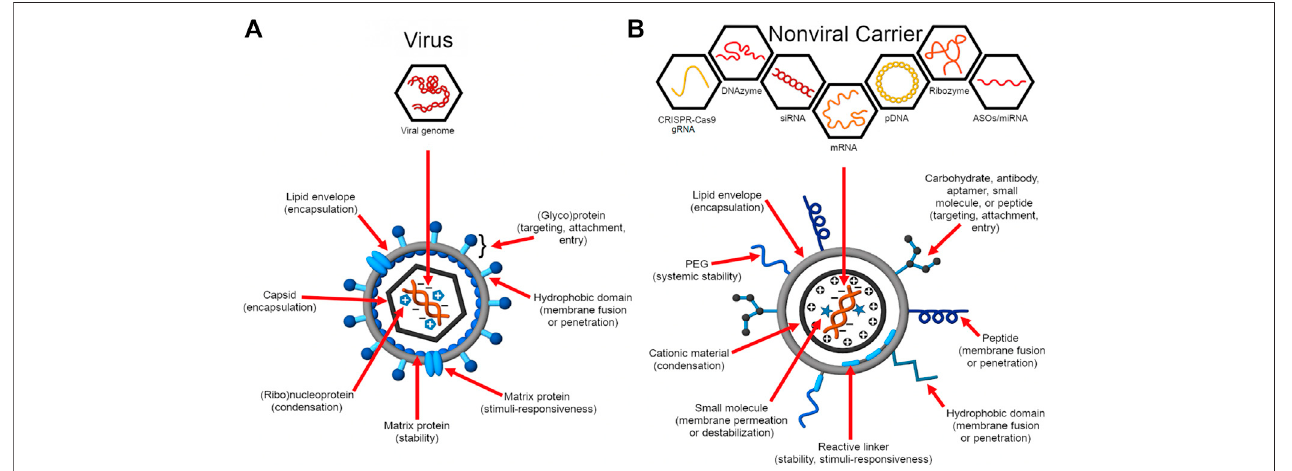
FIGURE 1 | Virus structure and function inform the design of nucleic acid delivery systems. (A) Viruses evolve to deliver their genome ef fi ciently to the host cell for replication (Flint et al., 2015). As such, their genome encodes proteins essential for genome protection, tropism, intracellular traf fi cking, controlled genome release, and replication. (B) SyntheticcarriersaredesignedtodeliveradiversityoftherapeuticnucleicacidcargoincludingpDNA,siRNA,ASOs,miRNA,mRNA,CRISPR-Cas9guide RNAs(gRNAs), ribozymes, and DNAzymes(Niet al.,2016; Ni et al.,2019).Analogoustoviruses, functionaldomains areembedded onthe construct thatenablea balance between nucleic acid protection and programmed, stimulus-induced